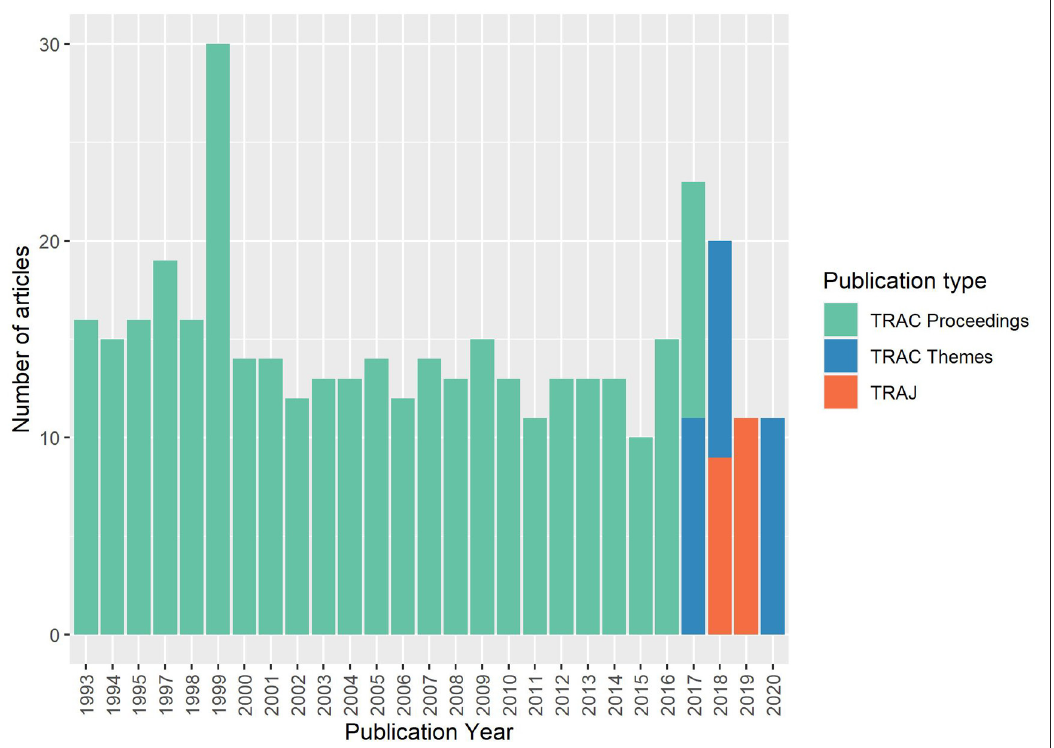
Figure 1: Number and type of TRAC publications published per